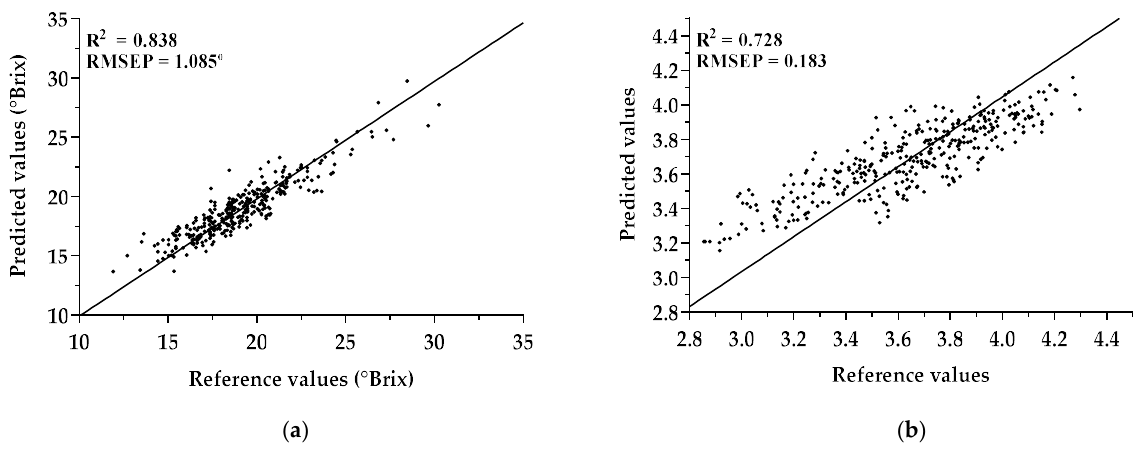
Figure 7. Prediction results of the TL-TF Model (2017) for ( a ) sugar measurements and ( b ) pH measurements.